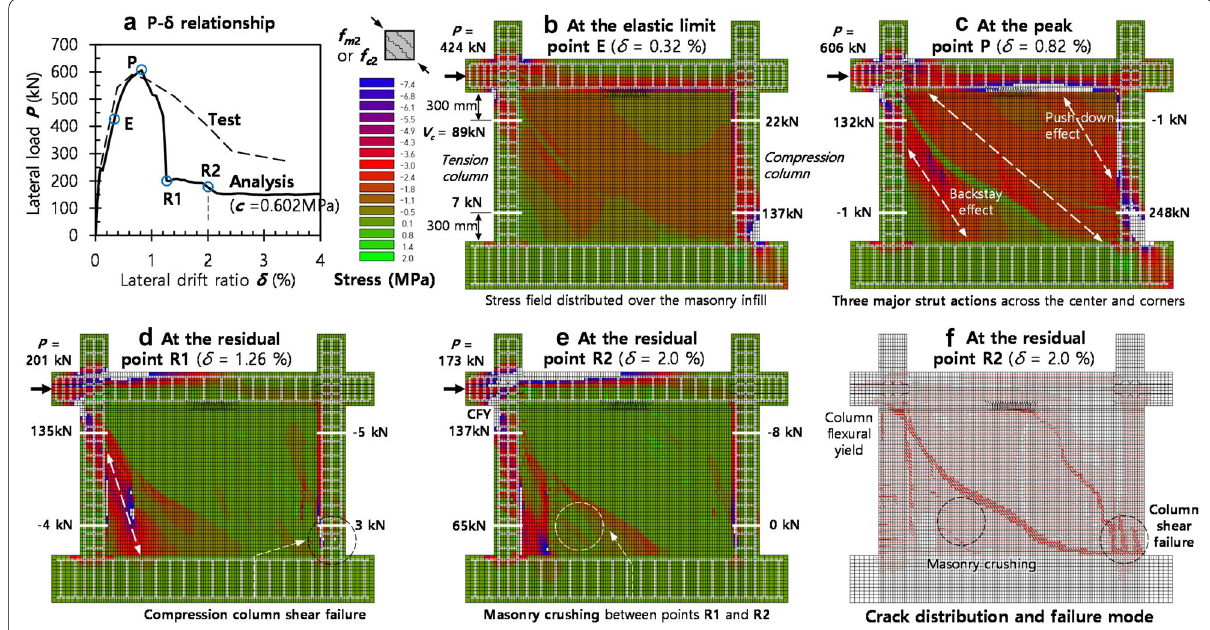
Fig. 7 Variation of stress distribution and force transfer with deformation: standard infilled frame IF1.0–strong masonry